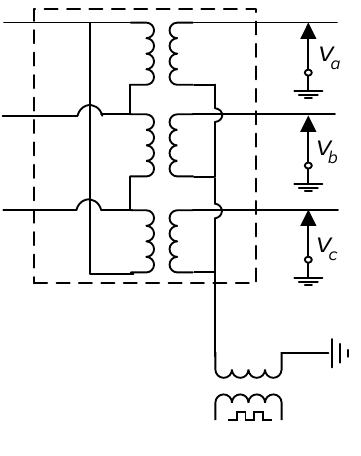
Figure 3: Injection transformer.